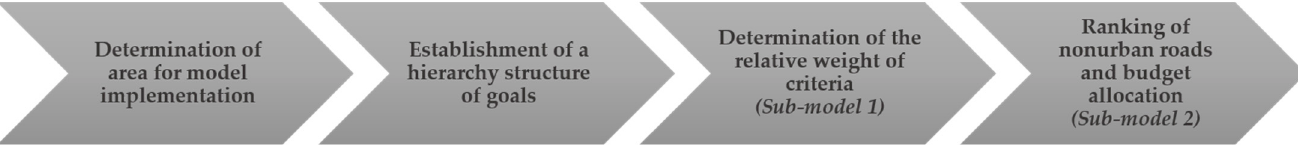
Figure 1. Maintenance management model for nonurban road network.